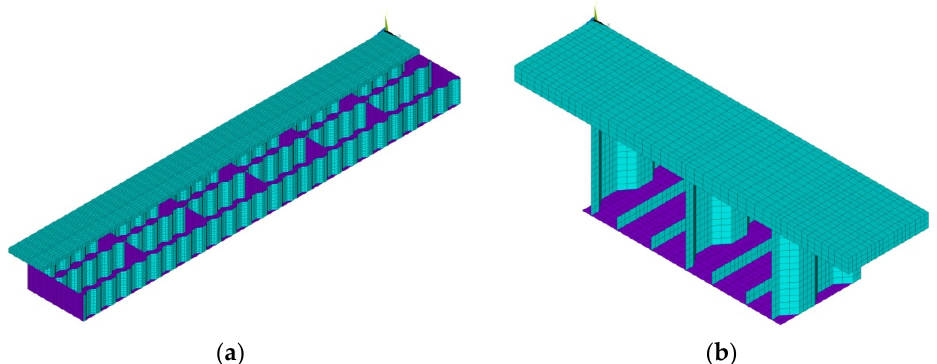
Figure 6. Finite element model:( a ) overall model; ( b ) local model.